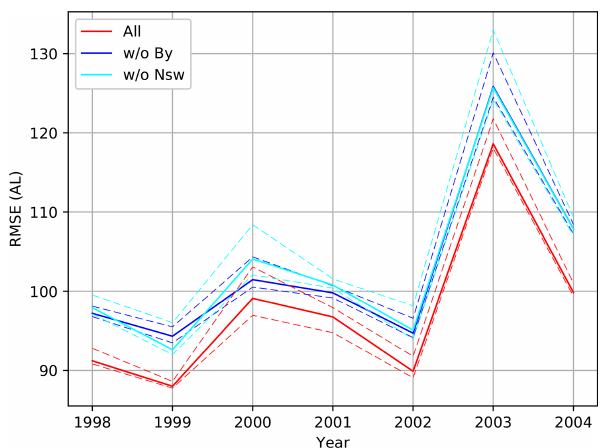
Figure 5. RMSE in each year for the various synthetic AL indices with the effect of one of the solar-wind parameters excluded.